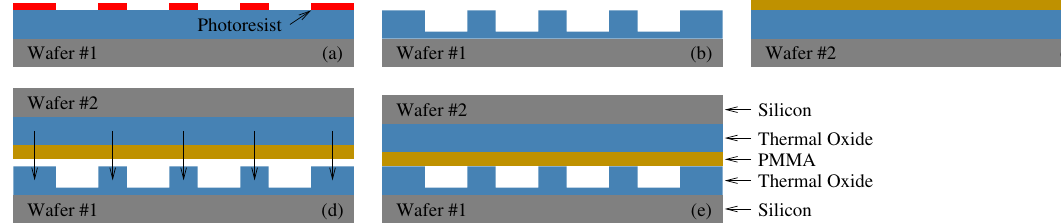
Figure 2. Process steps for CMUT fabrication: ( a ) pattern lithography and developing, ( b ) oxide etching and cleaning, ( c ) polymethyl methacrylate (PMMA) coating, ( d ) membrane and cavity alignment and bonding, ( e ) final structure.